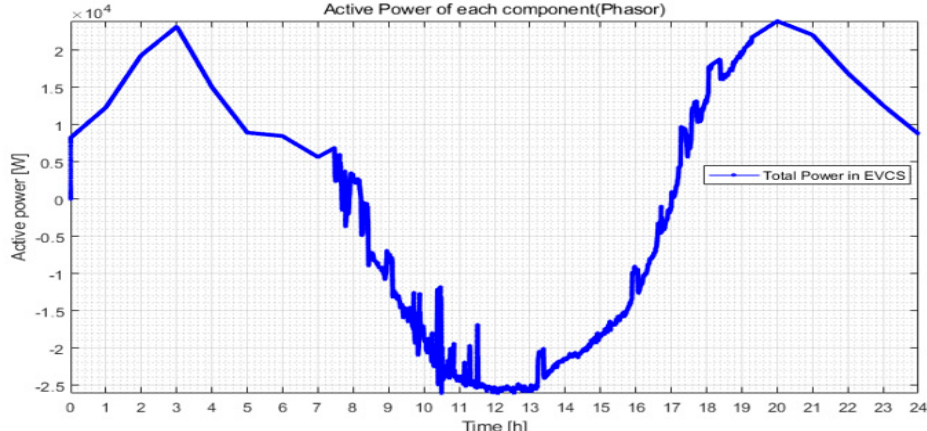
Figure 13. Analysis (power) of hosting capacity characteristic at EVC infrastructure without ESS.